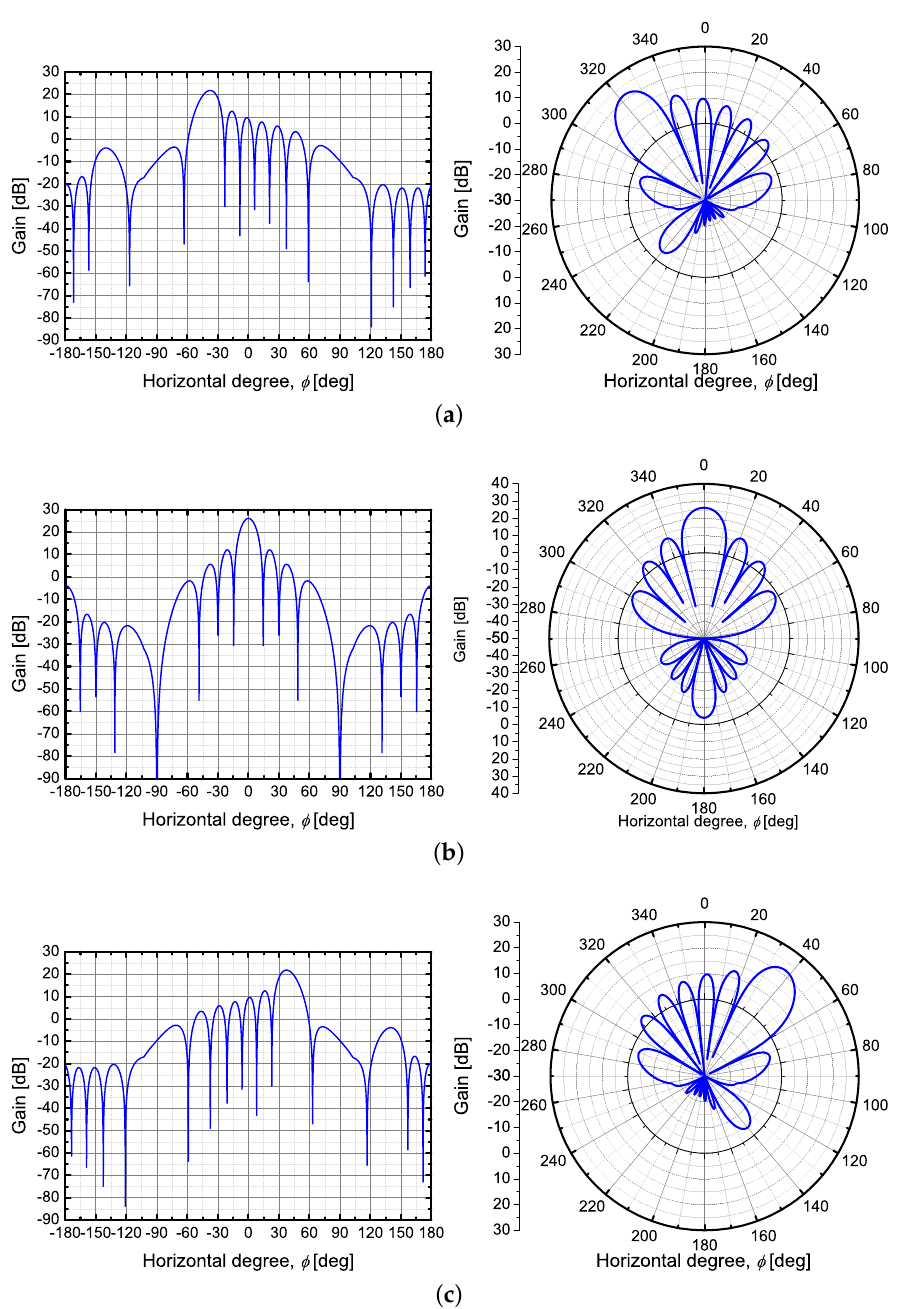
Figure 1. Example of the beam pattern in relation to L = 3 case. ( a ) beam pattern configuration in Cartesian (left plot) and polar (right plot) coordinate systems with G t ( 0 ) , ( b ) beam pattern configuration in Cartesian (left plot) and polar (right plot) coordinate systems with G t ( 1 ) , ( c ) beam pattern configuration in Cartesian (left plot) and polar (right plot) coordinate systems with G t ( 2 )